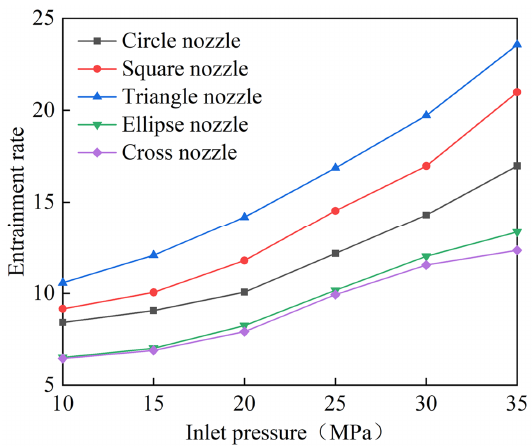
Figure 13. Entrainment rate of five nozzles under different inlet pressures when x = 100